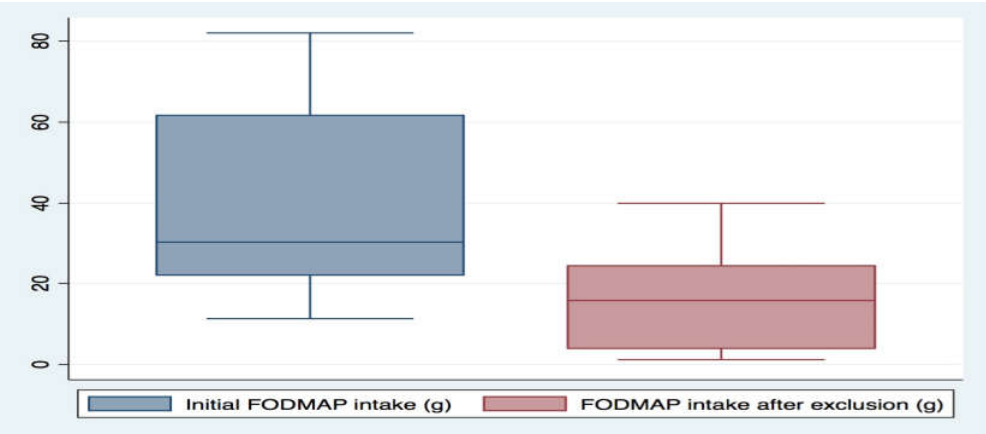
Figure 3. Total FODMAP (fermentable oligo-, di-, and monosaccharides, and polyols, gram per day) intake before (n = 8) and after (n = 5) commencement of low-FODMAP, gluten-free diet, as